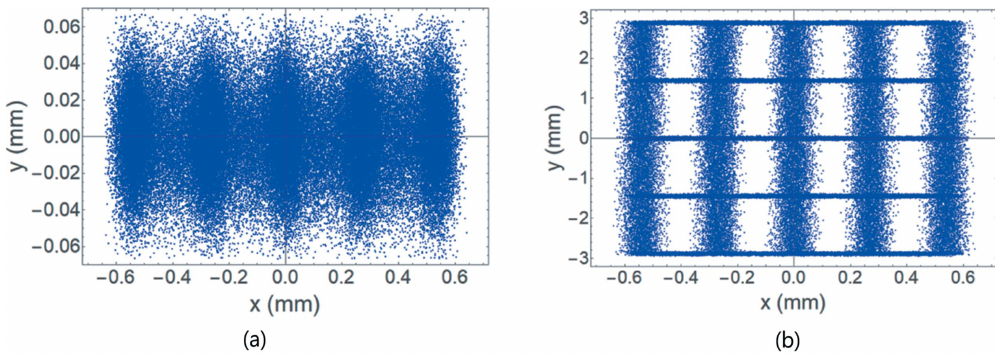
Figure 3 Beam distribution at the watching point with 100000 particles prepared for examination of intrinsic resolution. ( a ) TDC off; ( b ) TDC